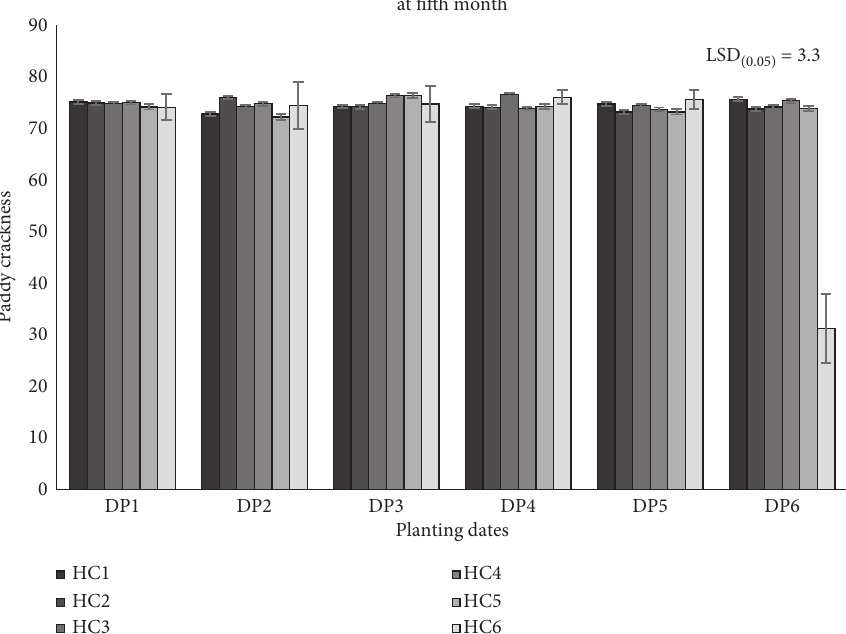
Figure 9: Effect of planting date and harvest cycle on paddy crackness at five months of storage in the Northern Savanna Agroecological Zone of Ghana. Bars represent the SEM. DP1 � first planting, DP2 � second planting, DP3 � third planting, DP4 � fourth planting, DP5 � fifth planting, DP6 � sixth planting, V1 � Agra, V2 � Gbewaa, V3 � Exbaika, V4 � Perfume Irrigated, HC1 � first harvest, HC2 � second harvest, HC3 � third harvest, HC4 � fourth harvest, HC5 � fifth harvest, and HC6 � sixth